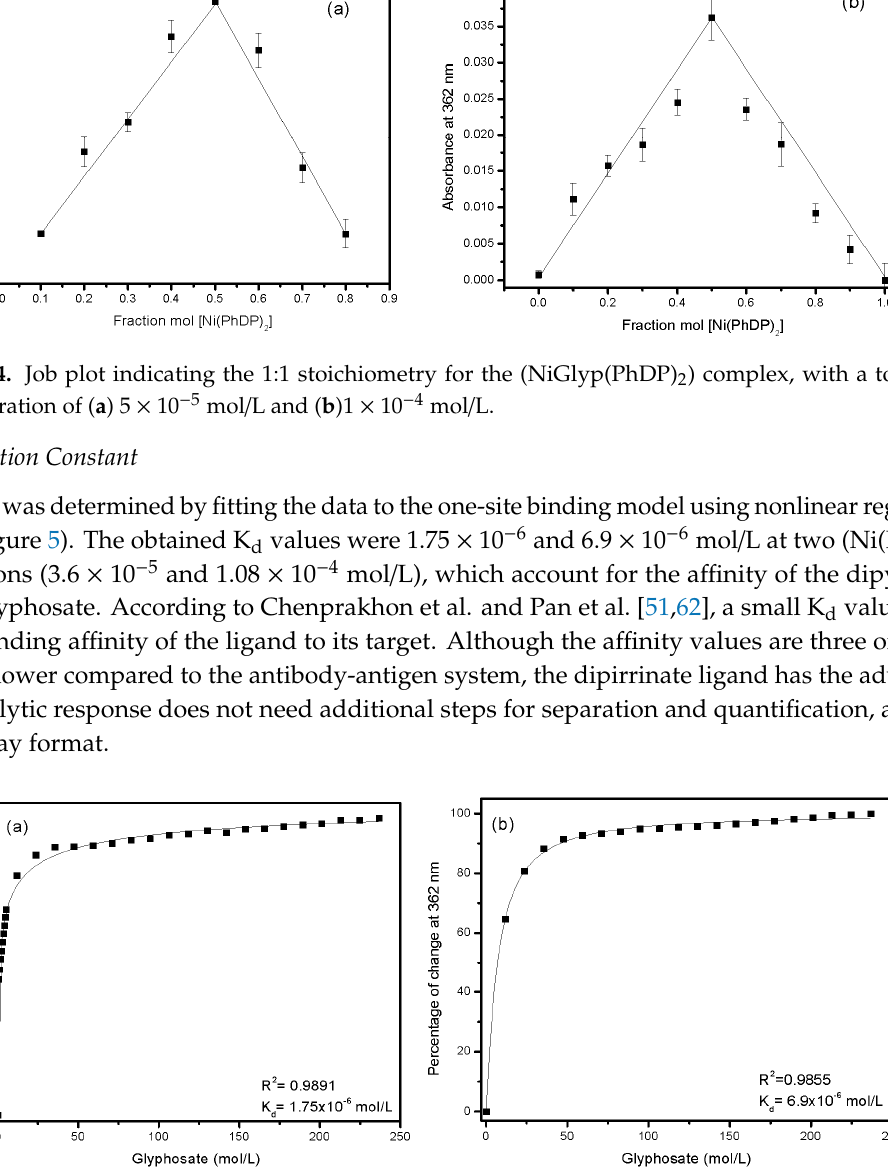
Figure 5. One site model fitting at ( a ) 1.08 × 10 − 4 mol/L of (Ni(PhDP) 2 ) and ( b ) 3.6 × 10 − 5 mol/L of (Ni(PhDP) 2 ) in the presence of glyp (5.9 × 10 − 7 to 2.36 × 10 − 4 mol/L).